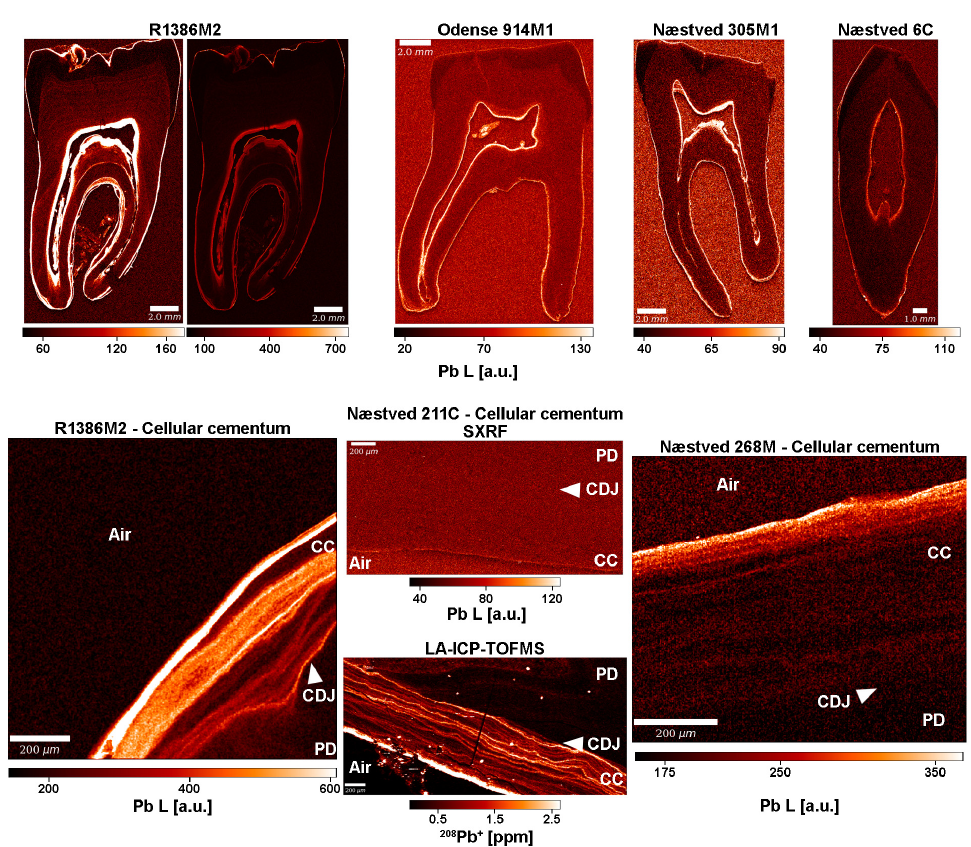
Figure 5. Uncalibrated SXRF Pb maps (detection of the Pb L lines) for the modern R1386M, Odense 914M, Næstved 305M, and 6C showing a preferential accumulation of Pb in the slow-forming secondary dentine and cementum ( top row ). Relative SXRF Pb enrichments and depletions are expressed in arbitrary units (“a.u.”). A very light alternation pattern of Pb is visible in the primary dentine of R1386M. This is confirmed at high-resolution ( bottom row ), where the cellular cementum of R1386M2 scanned in SXRF reveals a well-defined Pb pattern. In Næstved 268M, the surface of the cellular cementum is enriched in Pb, with a decreasing gradient involving an alternation of enrichments and depletions within the sub-surface. This Pb content fades away within the cellular cementum. Note that SXRF is not sensitive enough to resolve the Pb variation in the cellular cementum of Næstved 211C, while LA-ICP-TOFMS can quantify these variations with a high level of detail. “CC” stands for “cellular cementum,” “CDJ” for “cementodentine junction,” and “PD” for “primary dentine.” Graphic programs used: Adobe Photoshop CS6 and Adobe Illustrator